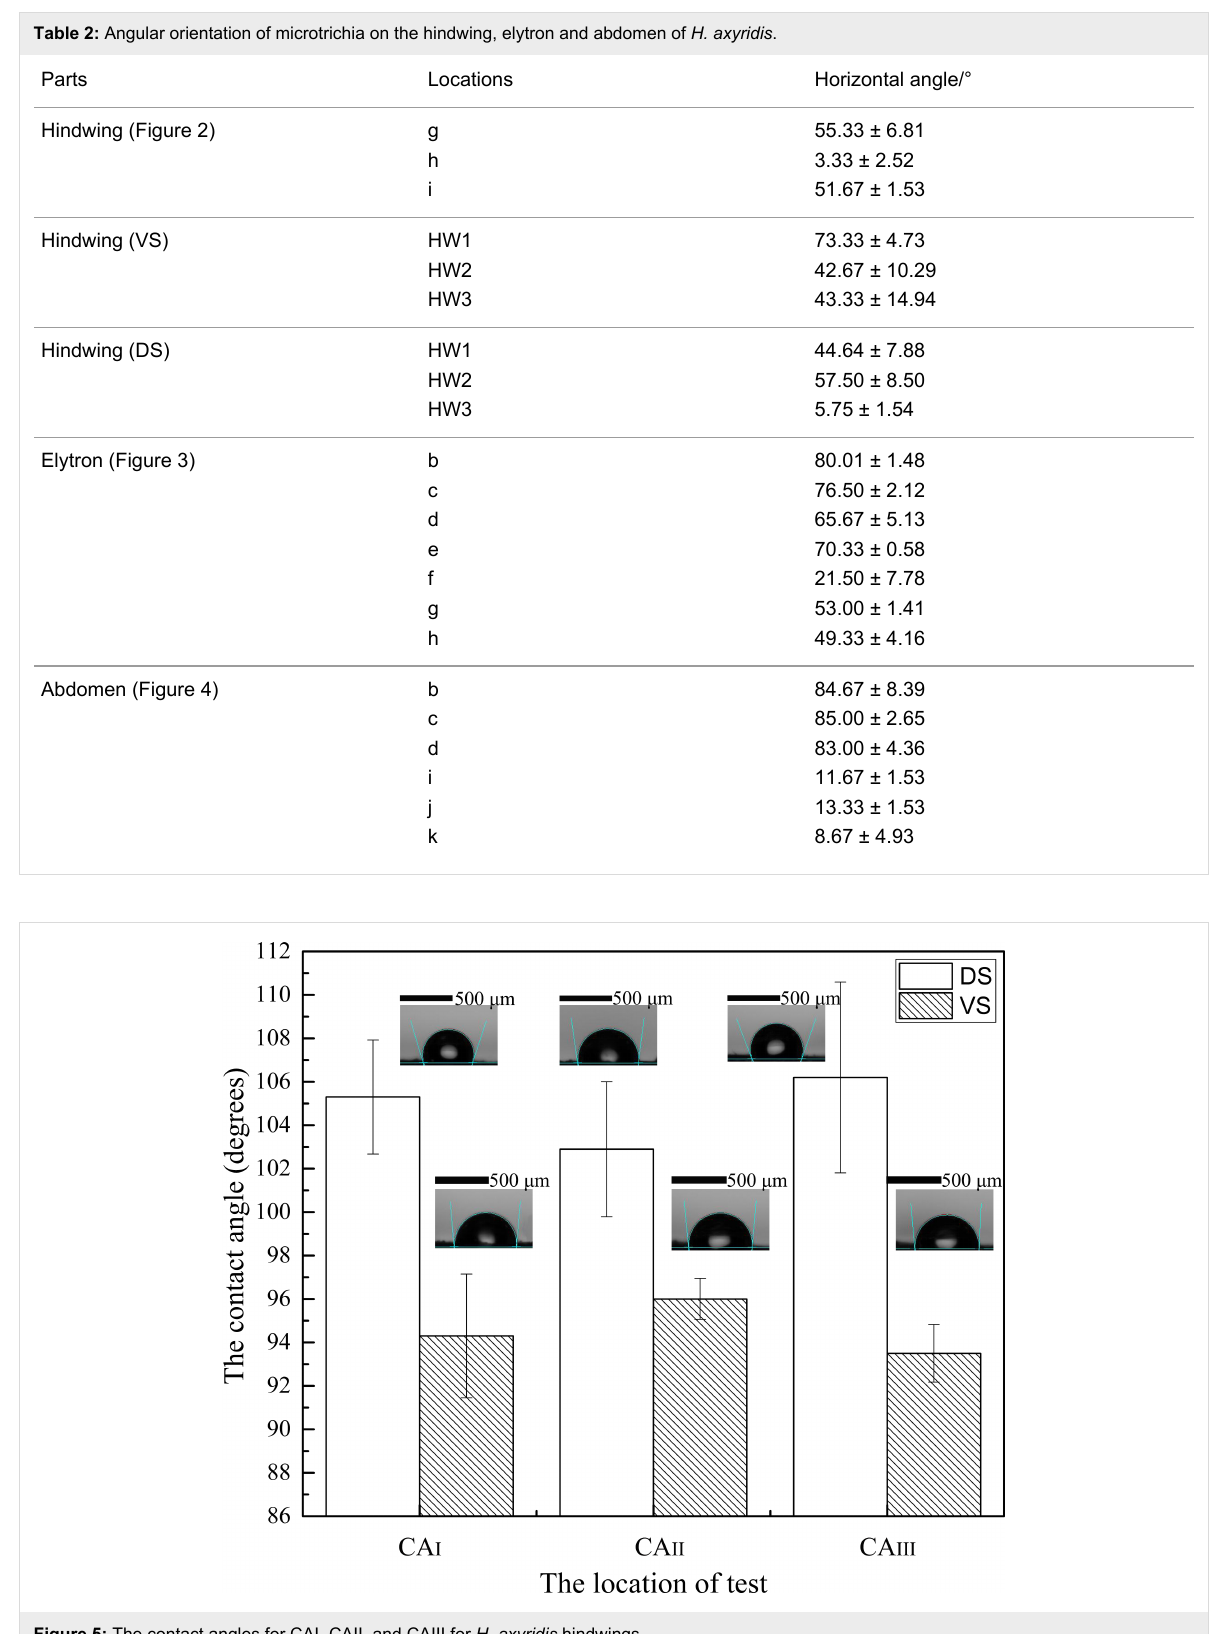
Figure 5: The contact angles for CAI, CAII, and CAIII for H. axyridis